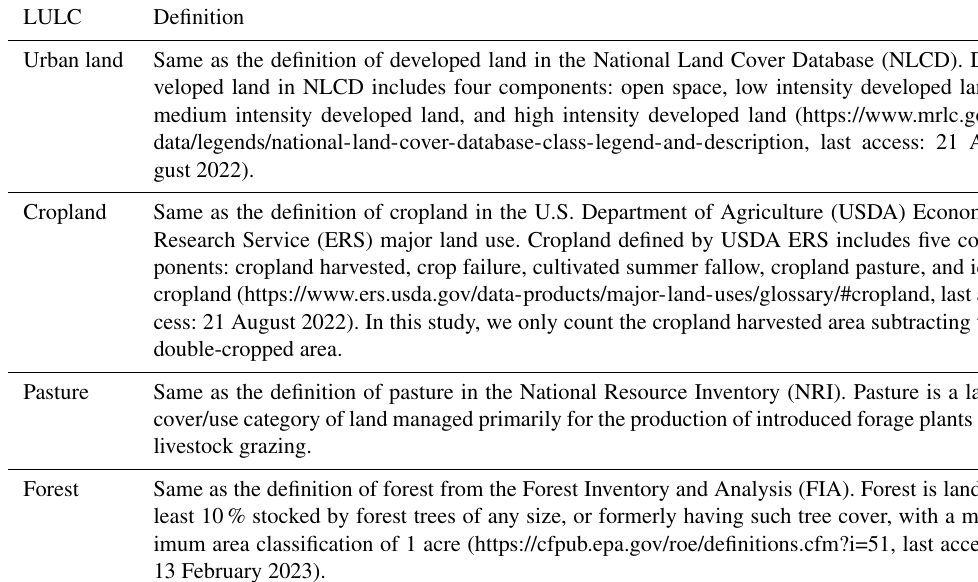
Table 2. Definitions of urban, cropland, pasture, and forest in this